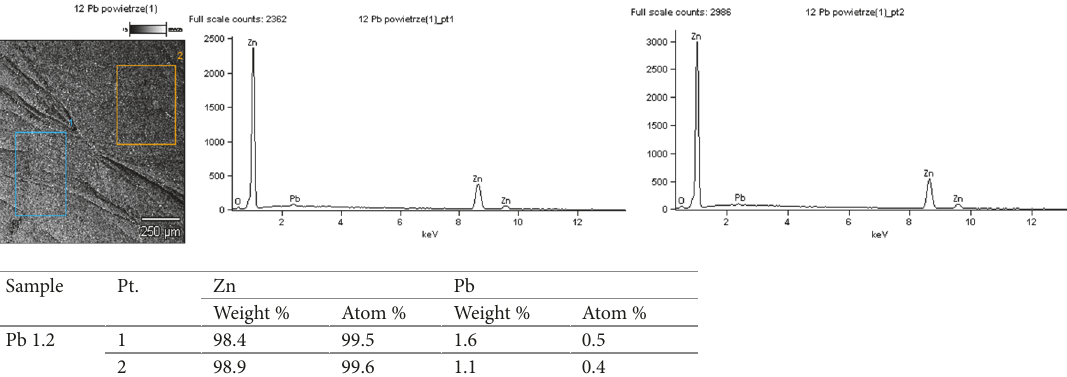
Figure 6: EDS analysis of Pb 1.2/air sample.